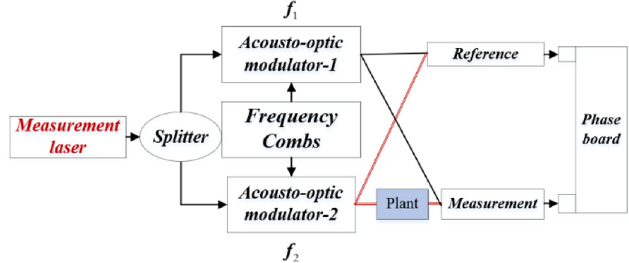
Fig. 2. Schematic of the functional optical fi ber sensor